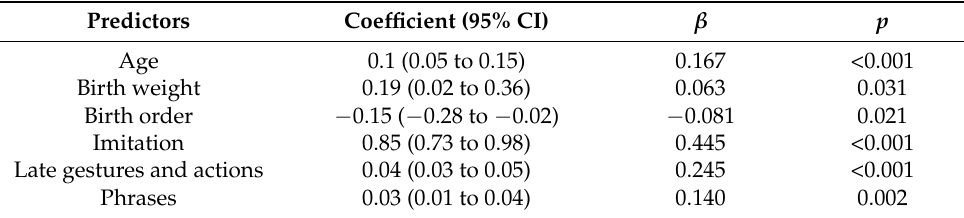
Table 3. Multivariate regression analysis of expressive vocabulary with respect to potential pre- linguistic and sociodemographic predictors.